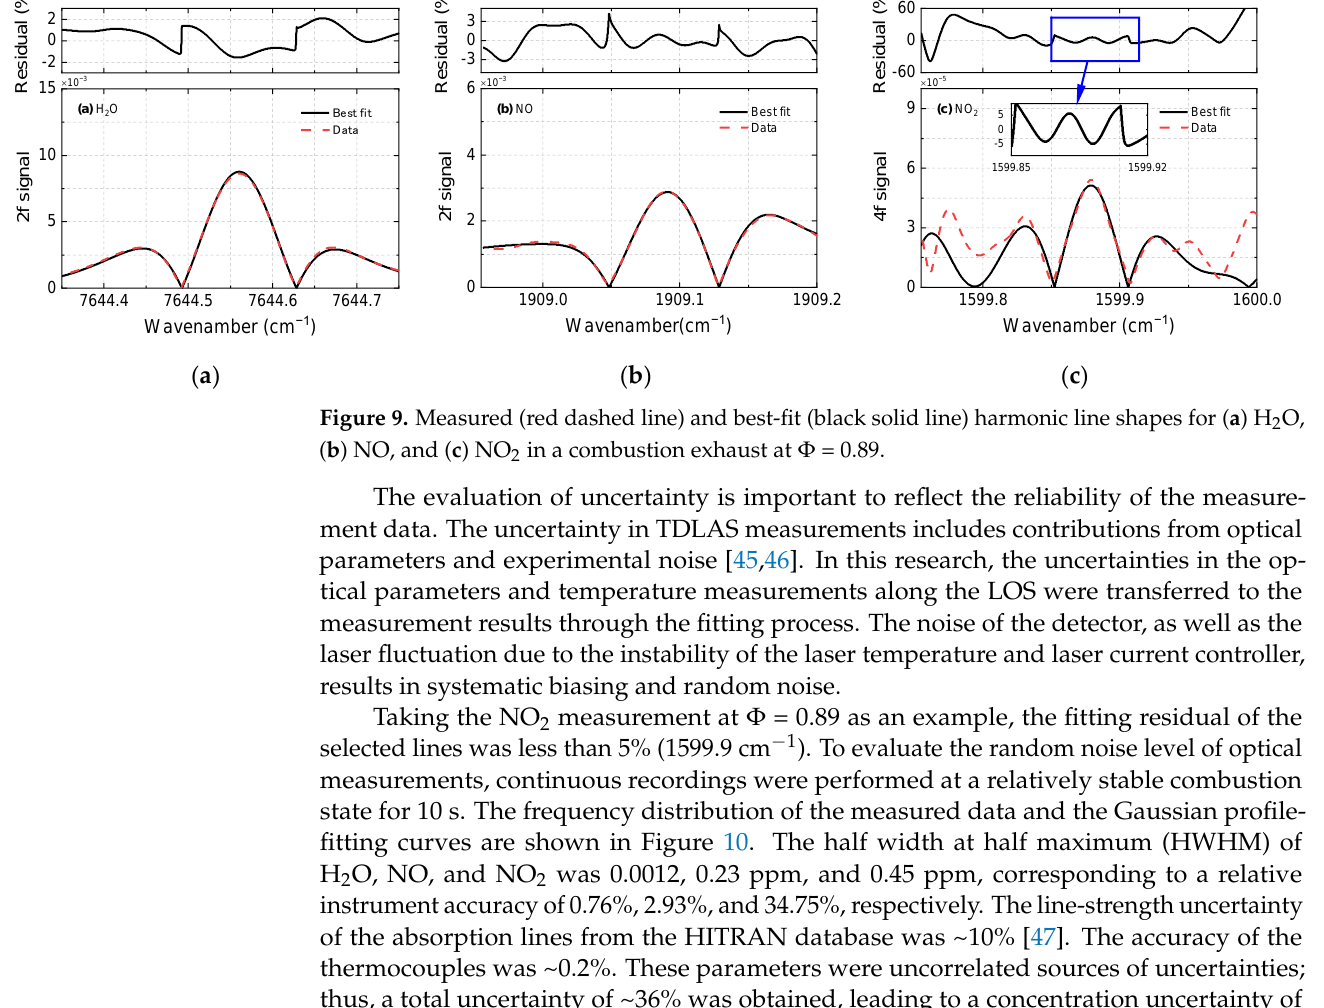
Figure 8. The temperature data along the optical length with typical experiment conditions at Φ = 0.89.